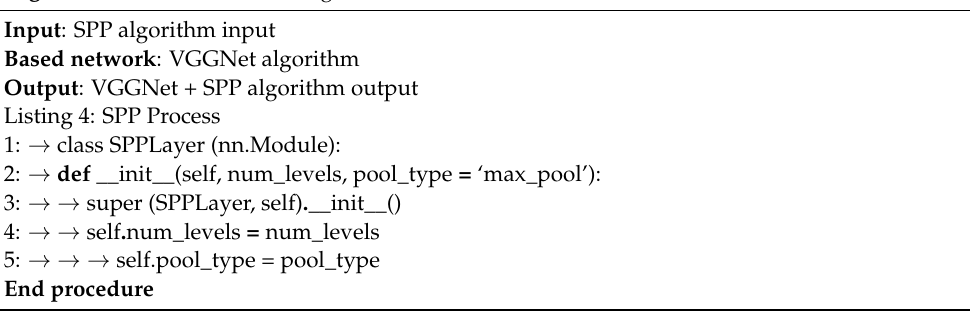
Figure 5. The model of VGGNet + SPP. Algorithm 4 : VGGNet + SPP